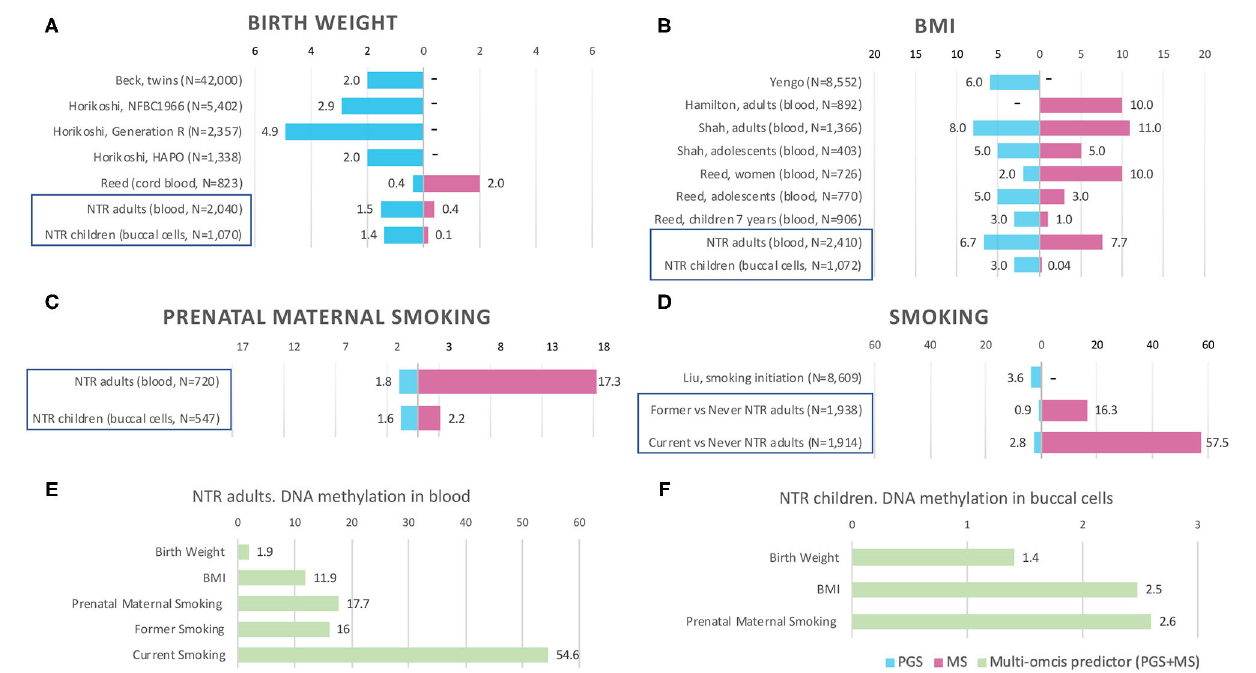
FIGURE 1 | Prediction by methylation and polygenic scores in previous studies and NTR. Bars are the phenotypic variance explained by the score ( R 2 ), x-axis shows R 2 in %. MS, methylation score. PGS, polygenic score. PGS + MS, polygenic and methylation scores in combined model (multi-omics predictor). “–” indicates that the score is not available in the study. Prediction by PGS and MS separately in NTR cohorts is indicated by blue frames in (A–D) . Multi-omics prediction in NTR is presented in (E–F) . Full references on previous studies in (A,B,D) can be found by first author in References. For more details on previous EWASs included in (A,B) , see Supplementary Table 1